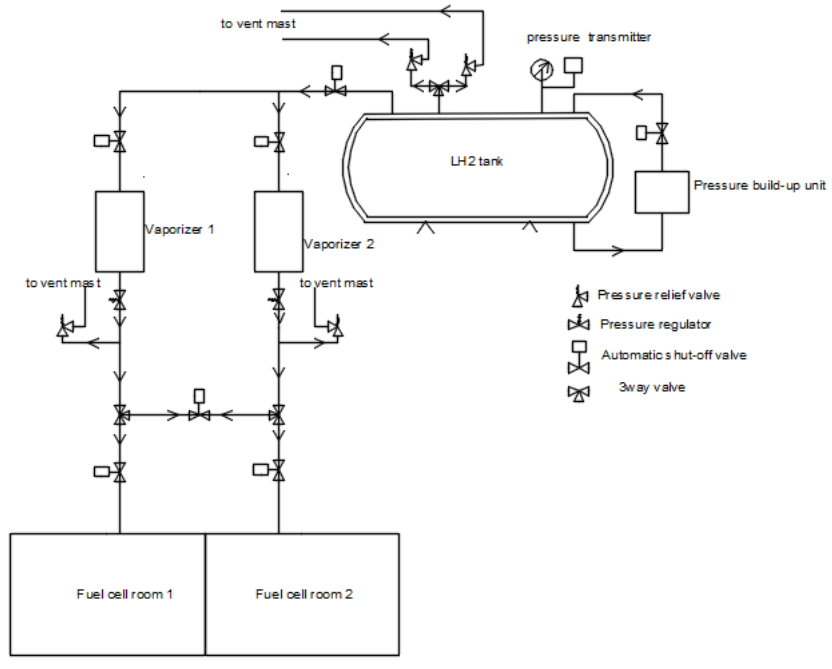
Figure 1. Onboard hydrogen systems.